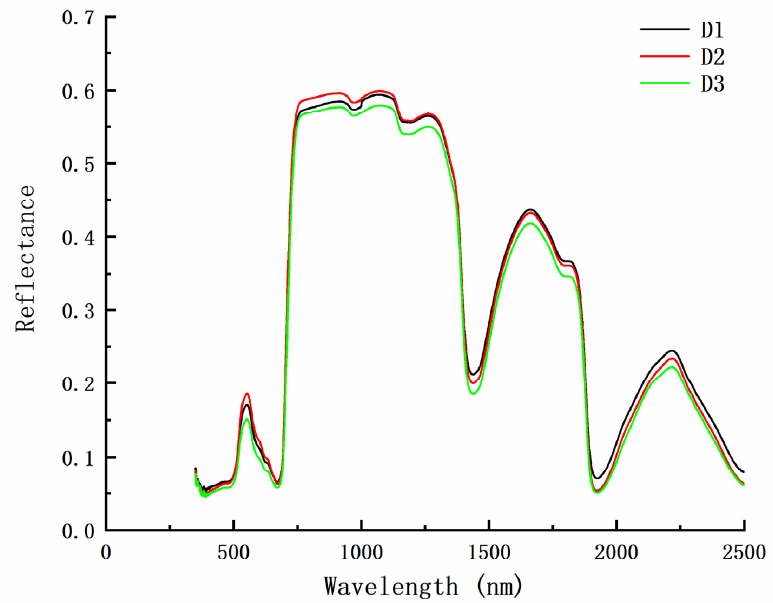
Figure 4. Spectral reflectance curves of peanuts of different plant densities under single seeding conditions.